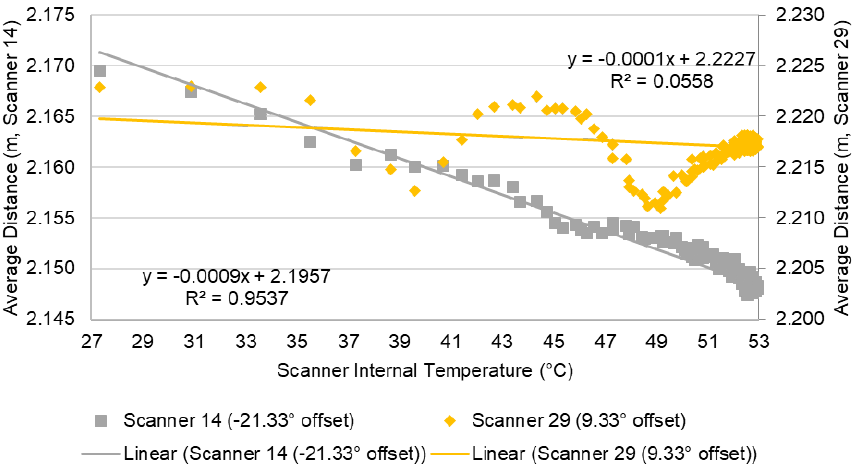
Figure 18. R 2 values for the linear trendlines and internal temperature/average measured distance for each of the Velodyne ® HDL – 32E’s individual channels.